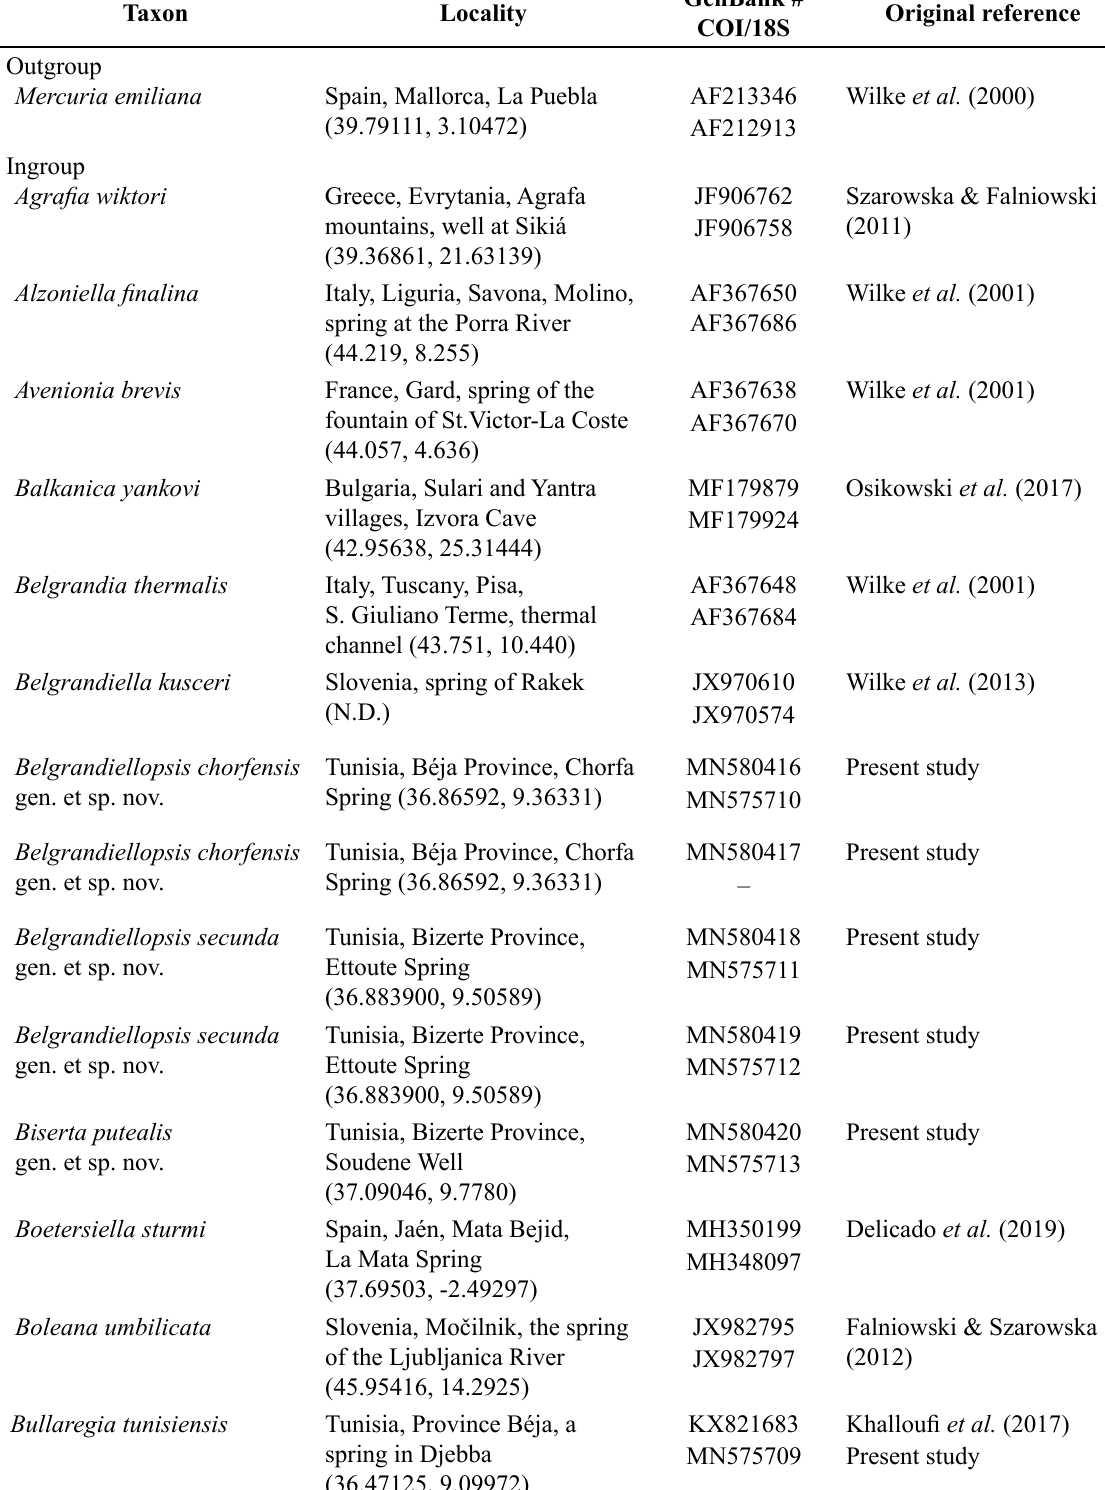
Table 1 (continues on the next two pages) . Taxa included in the molecular analysis with their corresponding locality names and geographical coordinates in decimal degrees, GenBank accession numbers and original references. N.D. = No